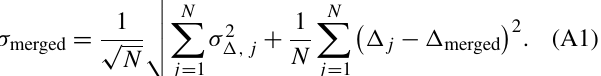
Figure A1. Schematic illustration (arbitrary y -axis scaling) of two extreme cases of individual anomalies and their uncertainties. Colored error bars: individual anomalies, black: merged (median) anomaly. (a) Significantly different individual anomalies with non- intersecting error bars, (b) nearly coinciding individual anomalies.